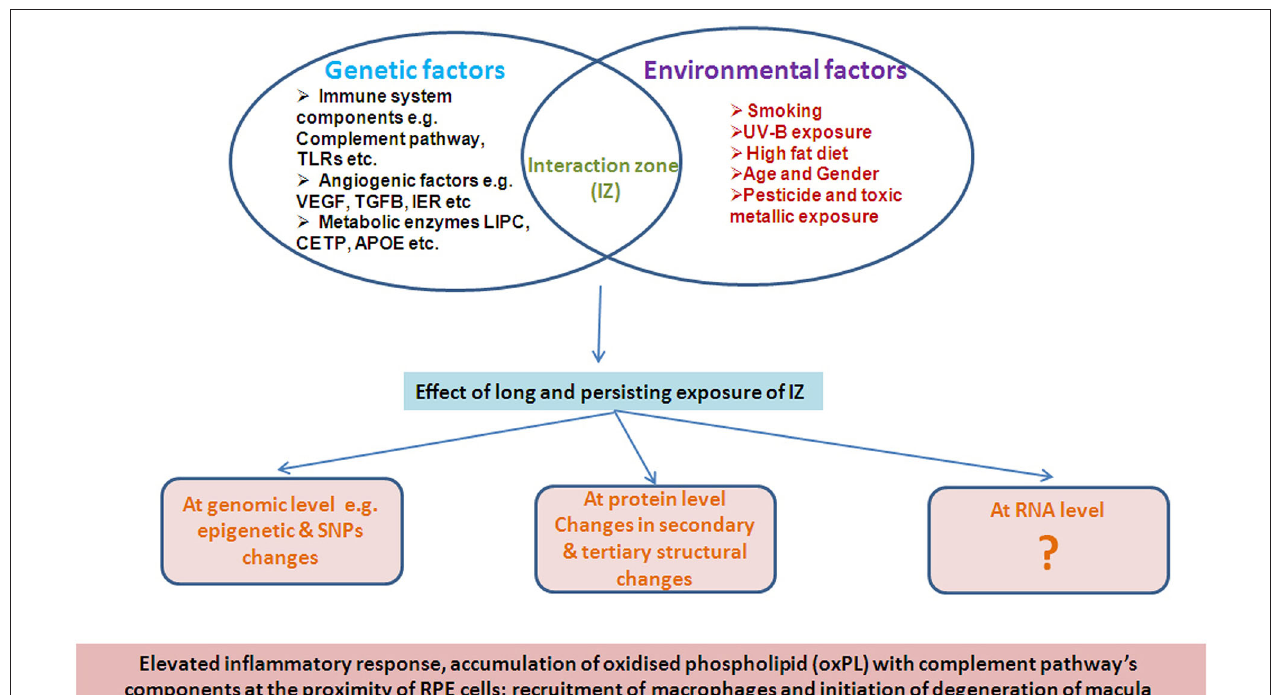
FIGURE 1 | Illustrative representation of interaction of Genetic and environment factors